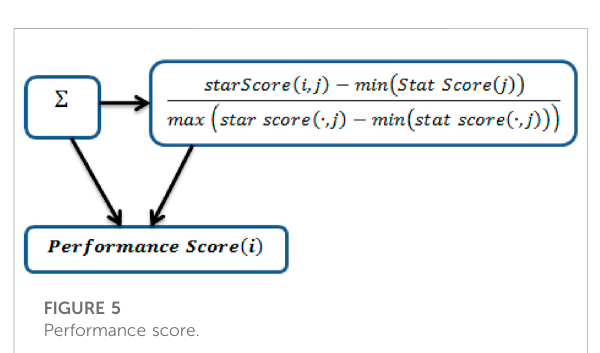
FIGURE 5 Performance score.